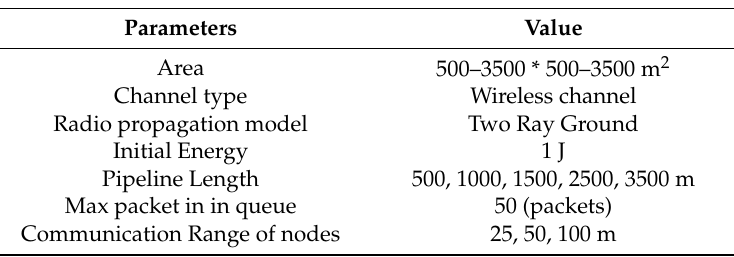
Table 1. Simulation